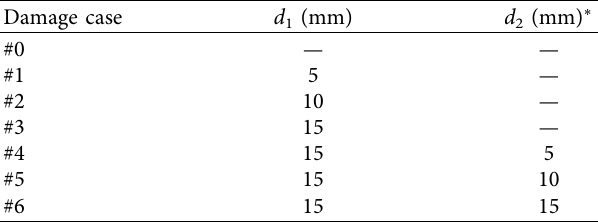
Table 4: Damage levels inserted in the box